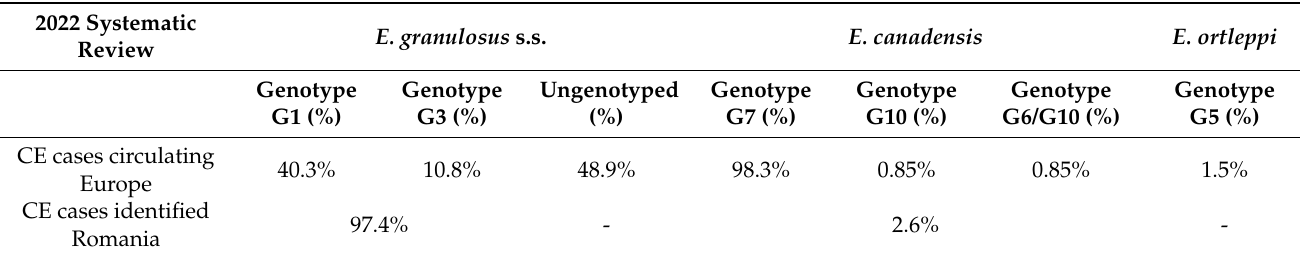
Table 1. Human CE cases molecularly confirmed in Europe (2020–2021). Data from Casulli A. et al. systematic review, 2022